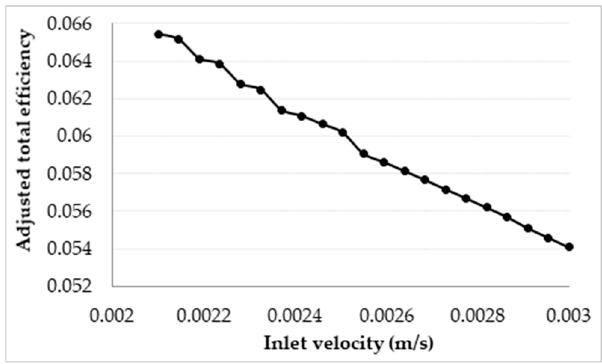
Figure 10. Adjusted total efficiency for a varying inlet velocity at a fixed receiver length of 1 m.